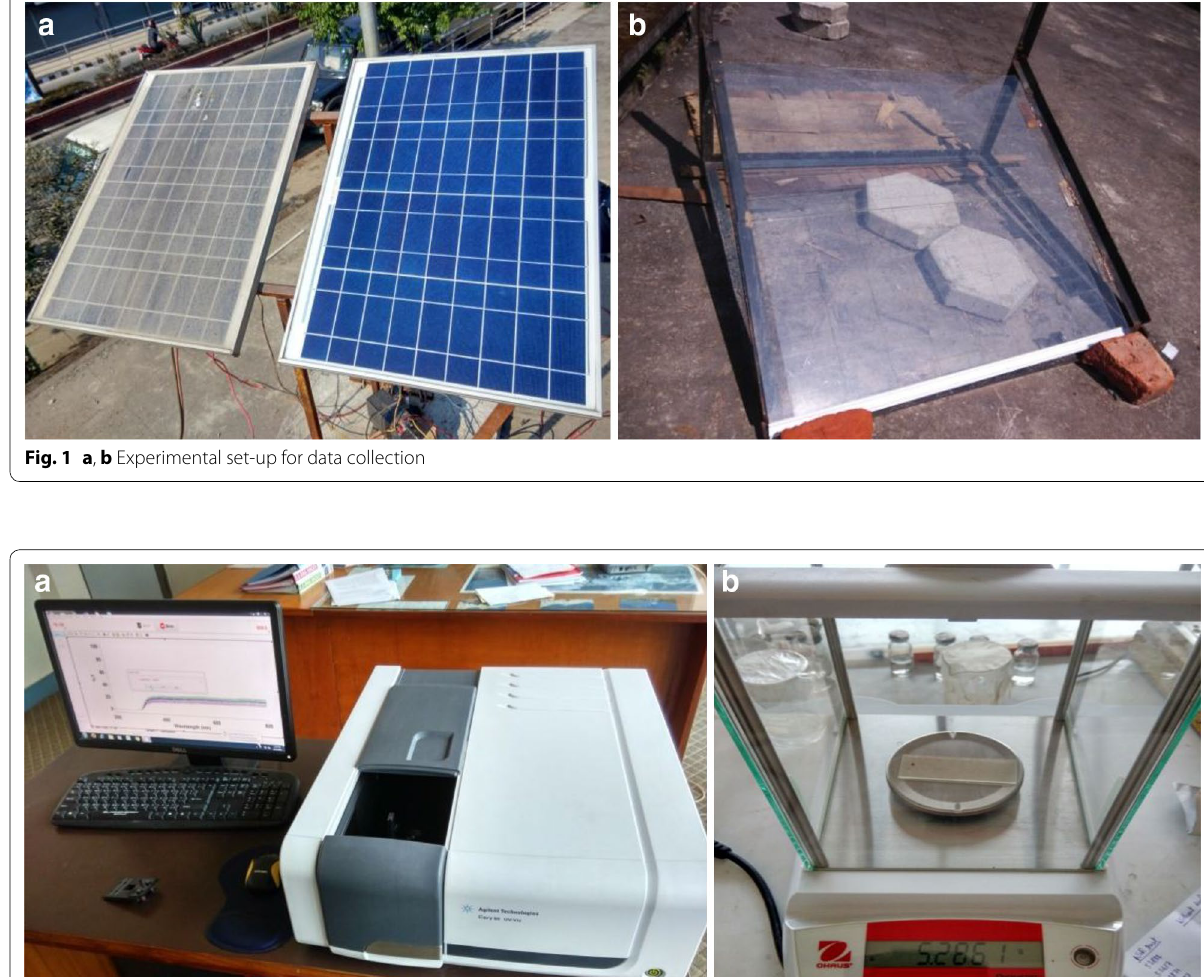
of modules was signalled by the varying values of Imp and V mp of both solar modules and recorded into the individual data loggers attached on each module.